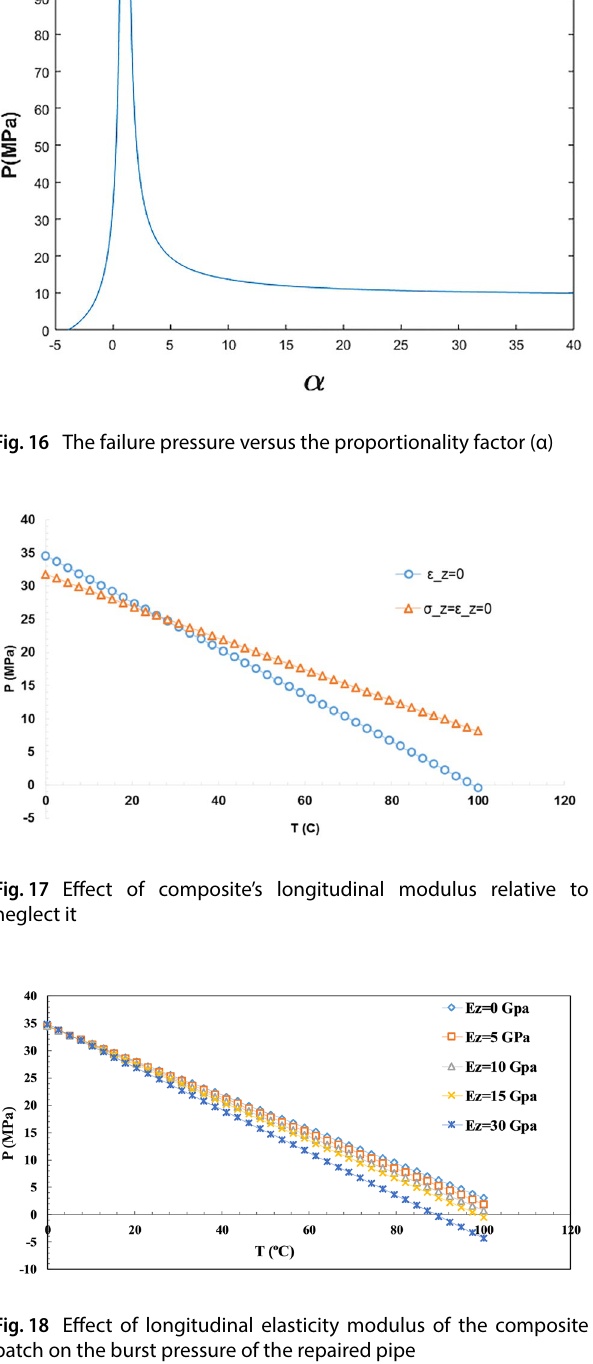
Table 2 Main parameters for the investigation of failure pressure [11, 16, 20, 21]